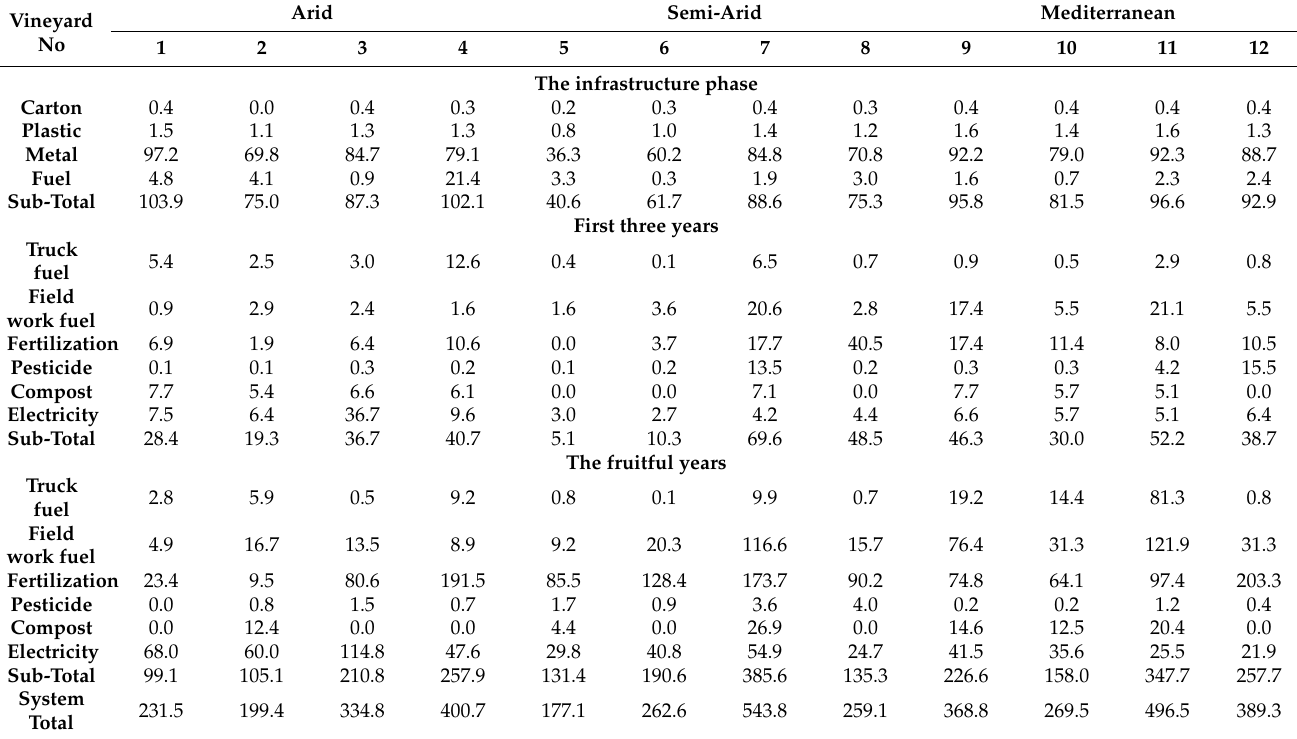
Table 2. Detailed contribution of life cycle stages to grape’s CF for each vineyard (kg CO 2 eq per ton of